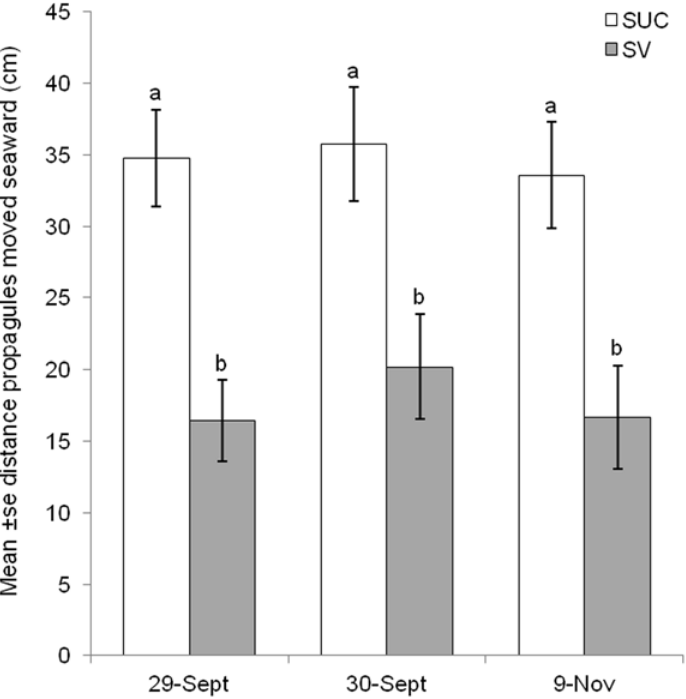
Fig 3. Distance moved by A . germinans propagules that dispersed seaward. Mean distance ± se (cm) seaward of initial position at which A . germinans propagules were recovered for saltmarsh grass monoculture (SV) or succulent-grass ecotone (SUC) treatments on three dates. Different letters above bars represent significantly different distances (RMANOVA).